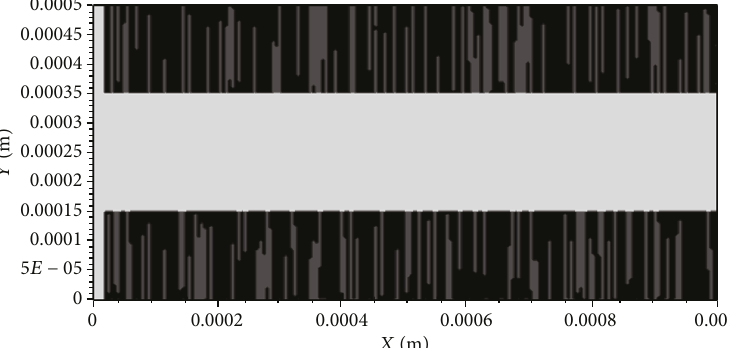
Figure 3: The geometry of a single fracture (in light gray) surrounded by reactive (in black) and nonreactive (in dark gray) minerals. In multispecies simulations, dark gray is kaolinite and black is calcite. The QSGS algorithm was used to grow nonreactive minerals inside a reactive mineral (in black) to form a banded structure.